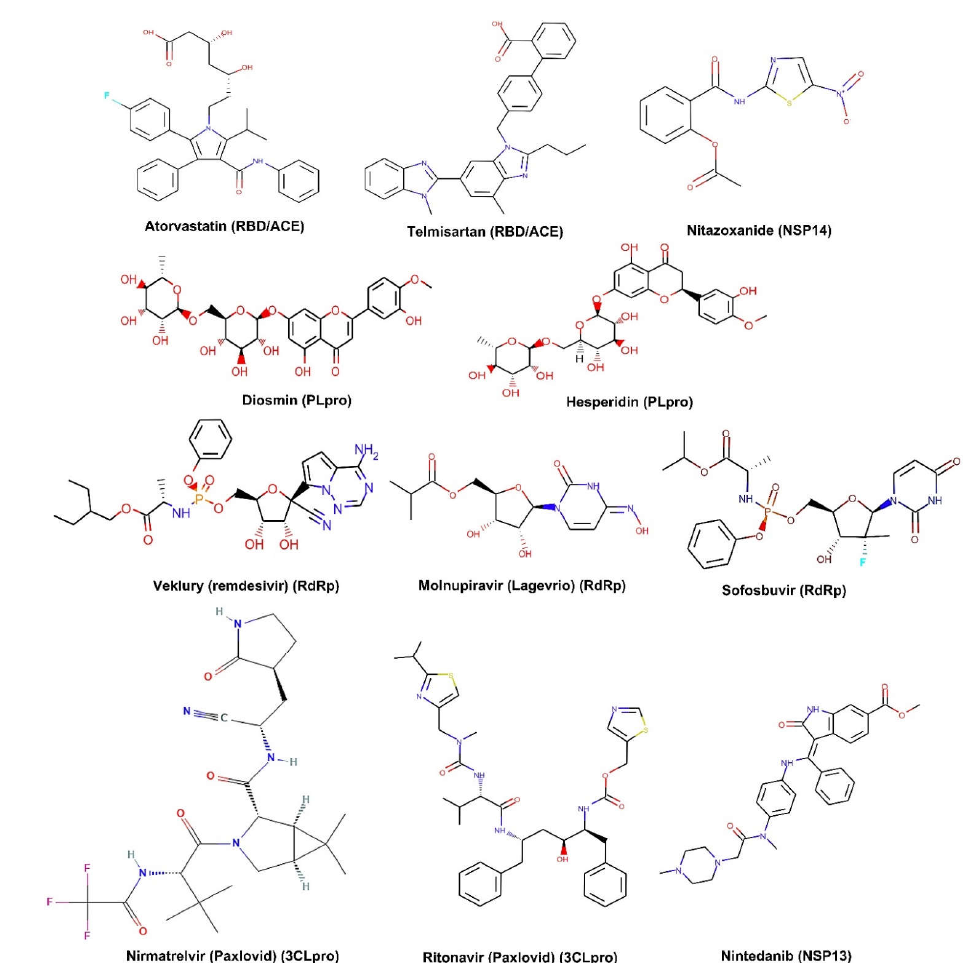
Figure 4. Small molecules targeting spike protein and nonstructural proteins of SARS-CoV-2. Abbreviations: ACE: angiotensin-converting enzyme 2; NSP: nonstructural protein; PLpro: papain-like protease; RBD: receptor-binding domain; RdRp: RNA dependent RNA polymerase; 3CLpro: 3C-like protease.